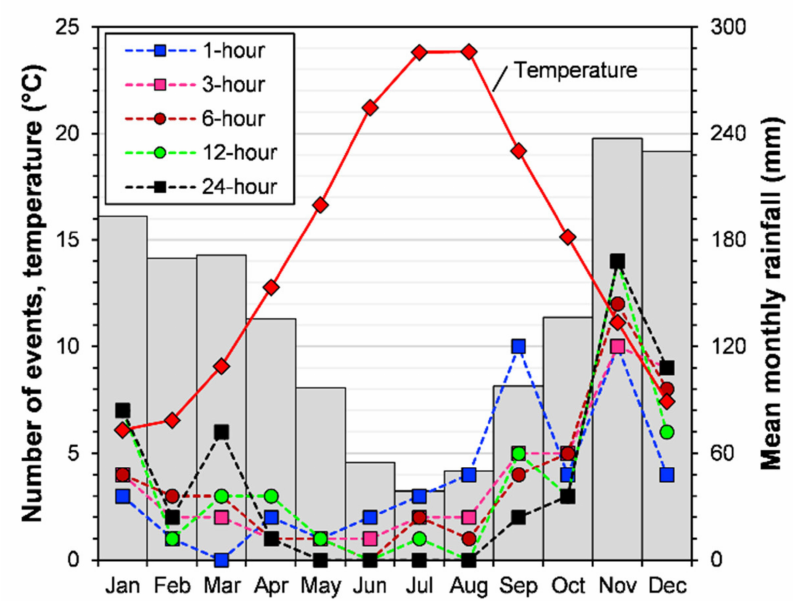
Figure 3. Main climate features of the S. Martino V.C. area; mean monthly rainfall (histogram; 1966–2020 period) and temperature (2002–2020 period). The number of times that the peak annual rainfall, for a given duration, falls in a particular month is also